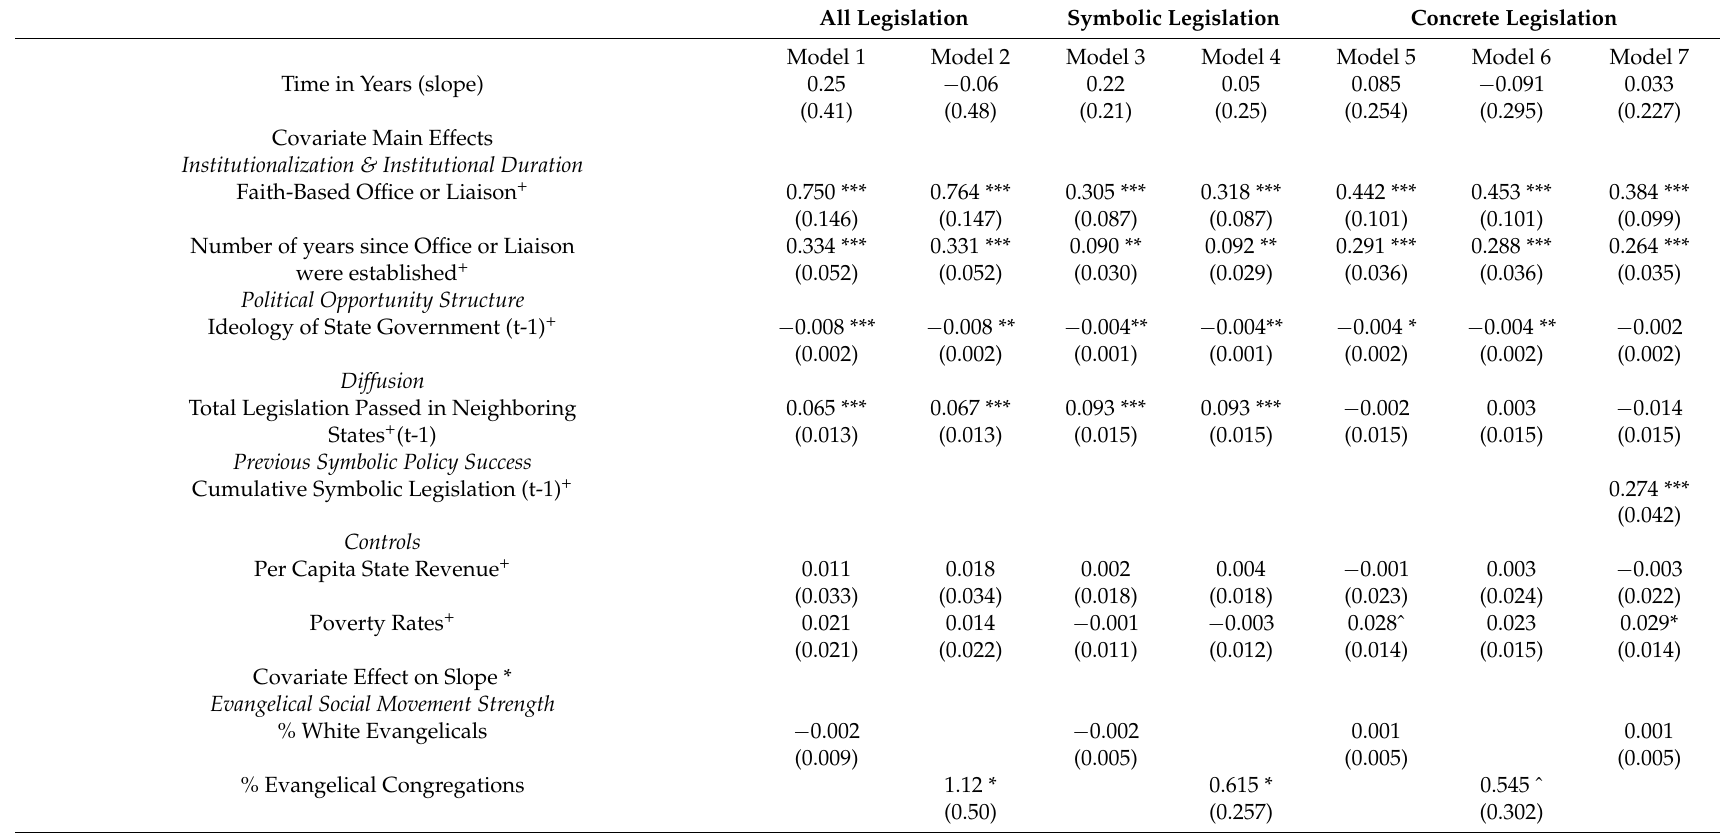
Table 5. MMC Analysis of Cumulative Total, Symbolic, and Concrete Faith-Based Legislation on State Charateristics: